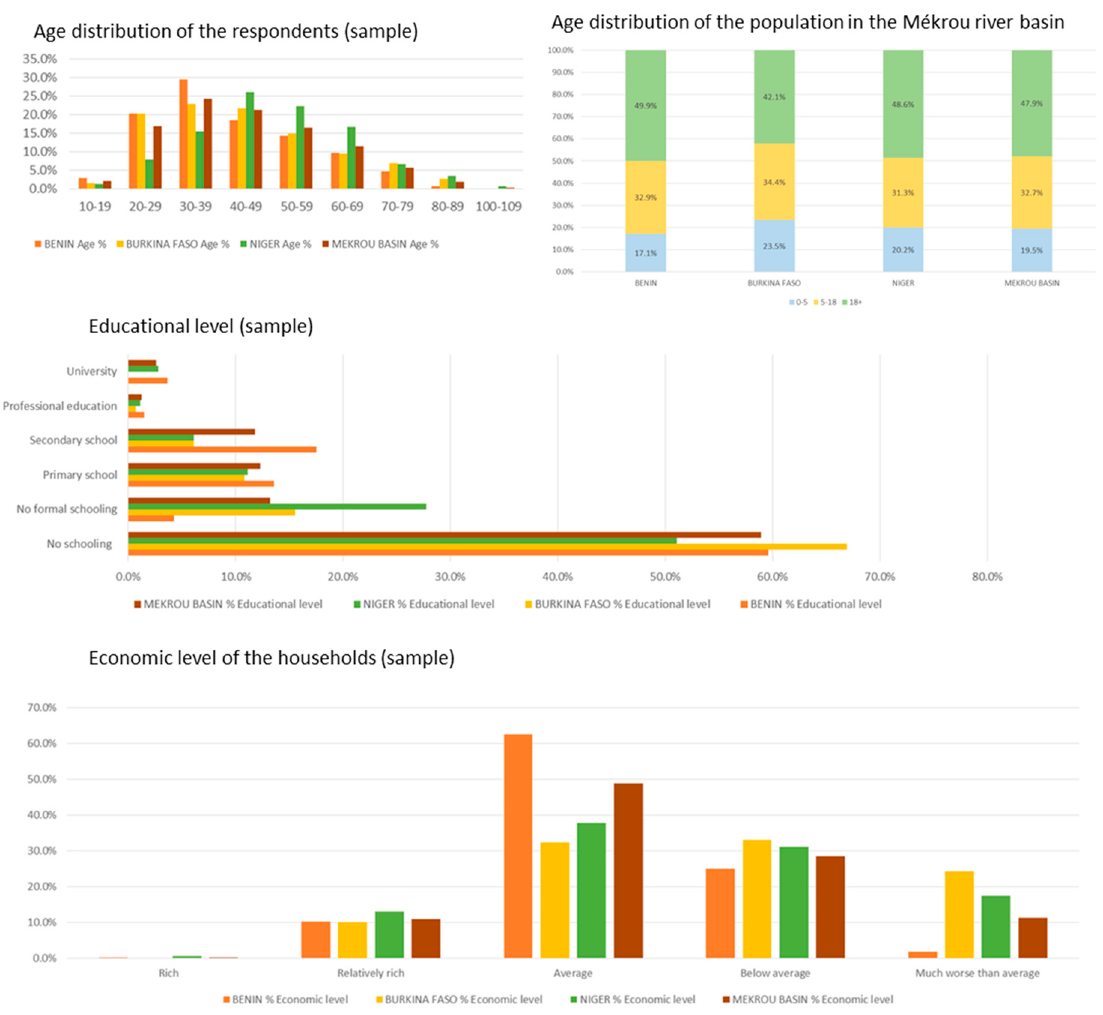
Figure 2. Main socioeconomic characteristics of the surveyed population.